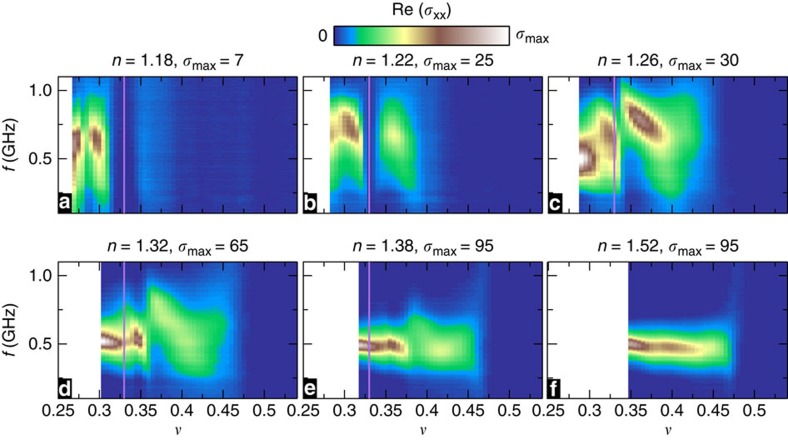
Electron density dependence of the transition.Plots of the microwave spectra, Re (σxx), in the (ν, f) plane at various densities, n. σmax is the largest Re (σxx) on the colour scale. Vertical lines mark ν=1/3 and the solid white area at low ν is outside the magnetic field measurement range. (a) For n=1.18, the FQHE around ν=1/3 appears as a region with a flat spectrum and vanishing Re (σxx)=0. A resonance is seen only for ν≤0.31, just below the FQHE state. At ν=0.285, the resonance peak (σpk) in Re (σxx) has a sharp minimum, interpreted as a transition within the solid. Possibly coincidentally, this ν is within error of 2/7. (b) On increasing to n=1.22, the resonance is re-entrant around the 1/3 FQHE and a minimum in σpk is located at ν=0.300. (c) For n=1.26, a resonance has replaced the FQHE at ν=1/3, while for ν=0.315 and 0.340 there are σpk minima, which are accompanied by jumps in fpk. (d,e) Data for n=1.32 and n=1.38, respectively. Each plot shows two minima in σpk with jumps in fpk. The jump in fpk is larger for the higher-ν (ν2) minimum in σpk. For ν above ν2 the resonance is broader with lower σpk. The jump in fpk for the lower-ν (ν1) transition at n=1.38 is much weaker than it is for lower n. (f) Data for n=1.52, at which both transitions have disappeared, and fpk and the resonance amplitude vary only marginally throughout the measurement range.